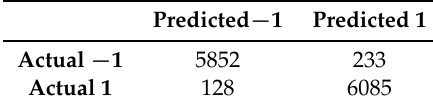
Table 1. 10-fold cross-validation results of the gradient boosting tree (GBT) classifier for stride